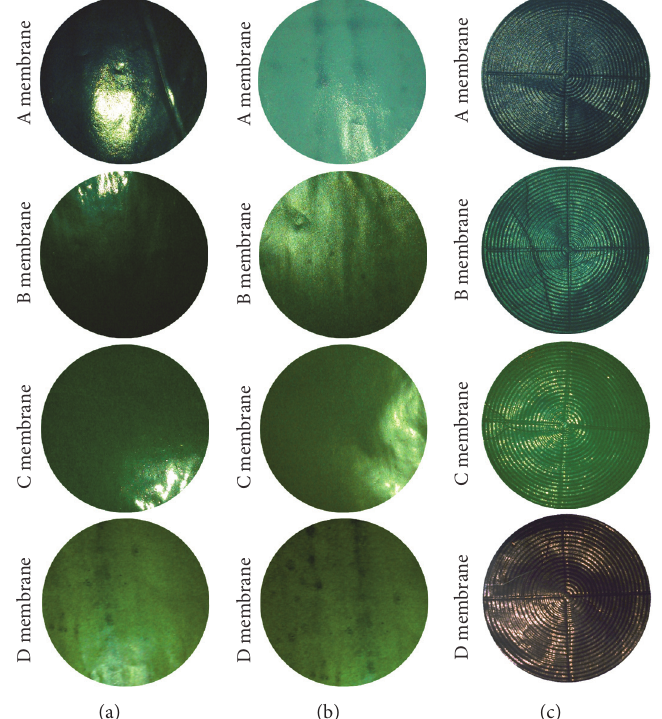
Figure 2: Images of PAN/PANI membrane surfaces: (a) skin layer, (b) carrier layer, and (c) skin layer after transport properties testing.